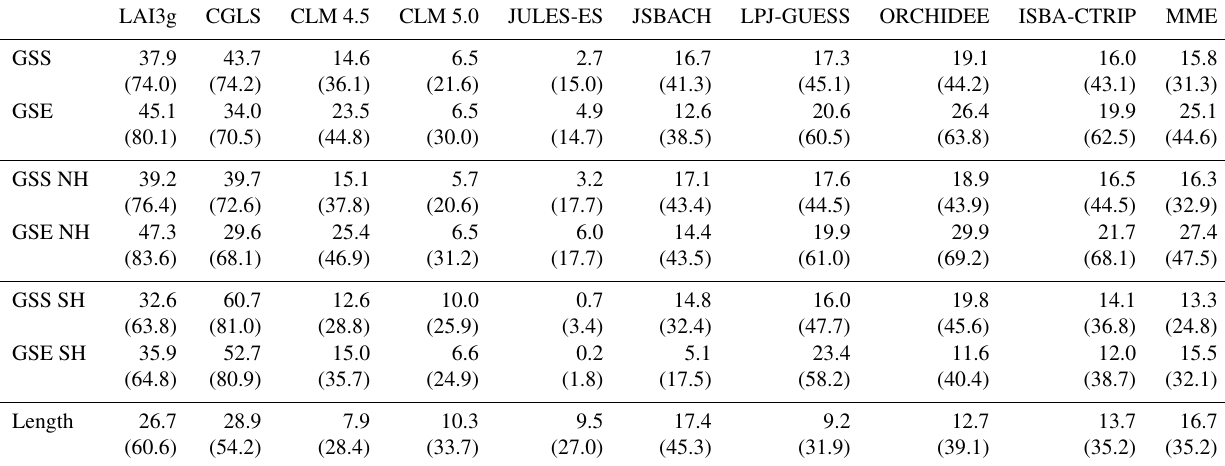
Table 3. The fraction of land grid cell in agreement with MODIS for LAI3g, CGLS, each land surface model, and multi-model ensemble mean (MME) in the growing season start (GSS) and growing season end (GSE) timings. Values are reported in percentages for global, Northern Hemisphere (NH), and Southern Hemisphere (SH). Green shaded areas in Figs. 4 and 5. The last row reports the fraction of land grid cell in agreement with MODIS for each land surface model in growing season length. The values in brackets give the percentage of global, NH, and SH with a maximum difference of 1